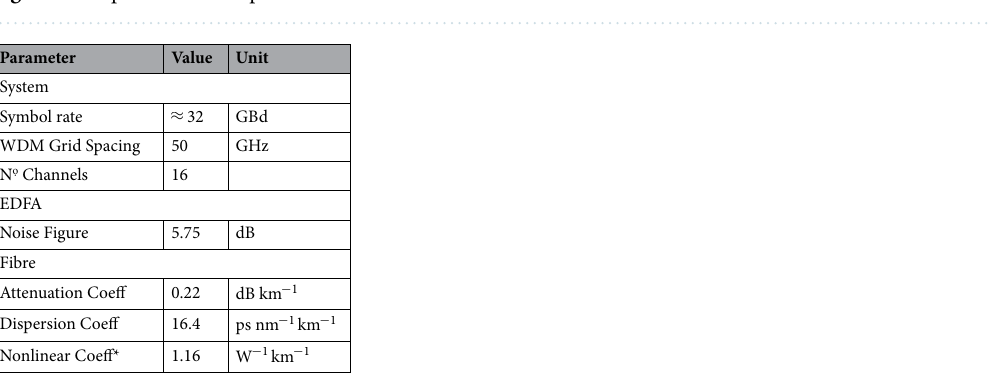
Figure 5. Experimental setup.